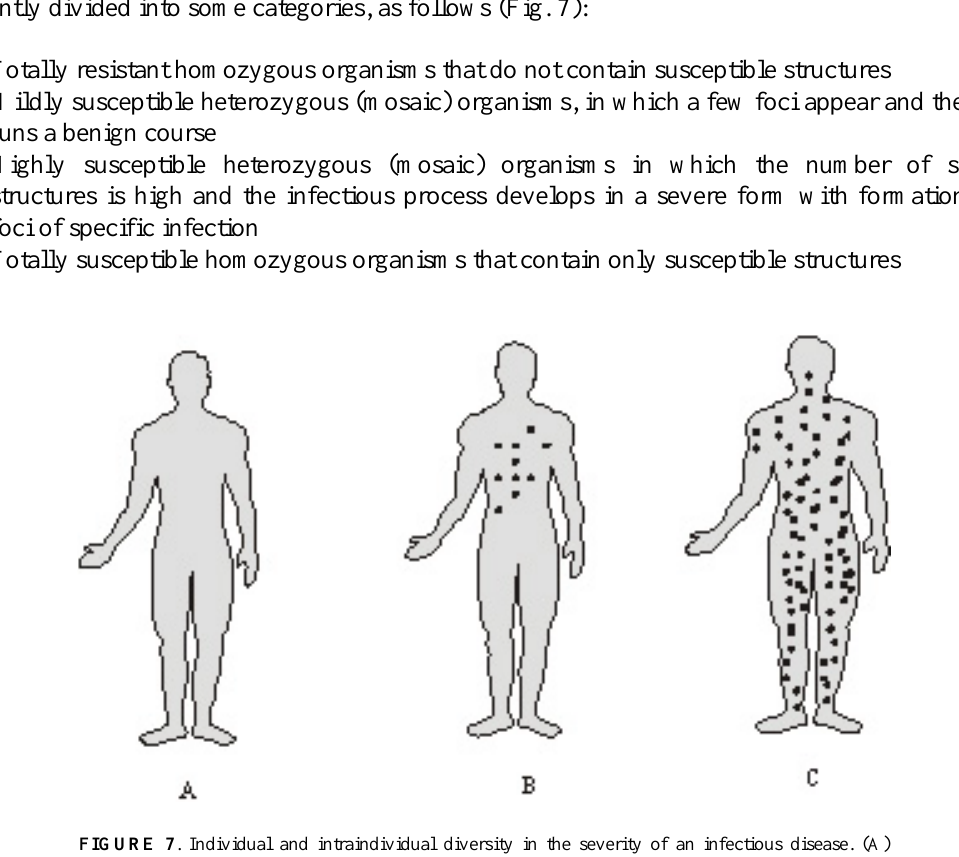
FIGURE 7 . Individual and intraindividual diversity in the severity of an infectious disease. (A) Totally resistant organism that does not contain susceptible structures, (B) mildly susceptible organism in which a few sensitive foci exists and the disease runs a benign course, (C) organism in which the number of constitutionally susceptible structures is high and the disease develops in a severe